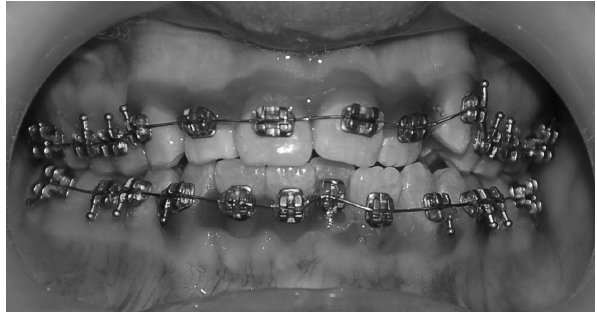
Fig. 2. The application of the photosensitizer on the mucous membrane of marginal periodontal tissue.